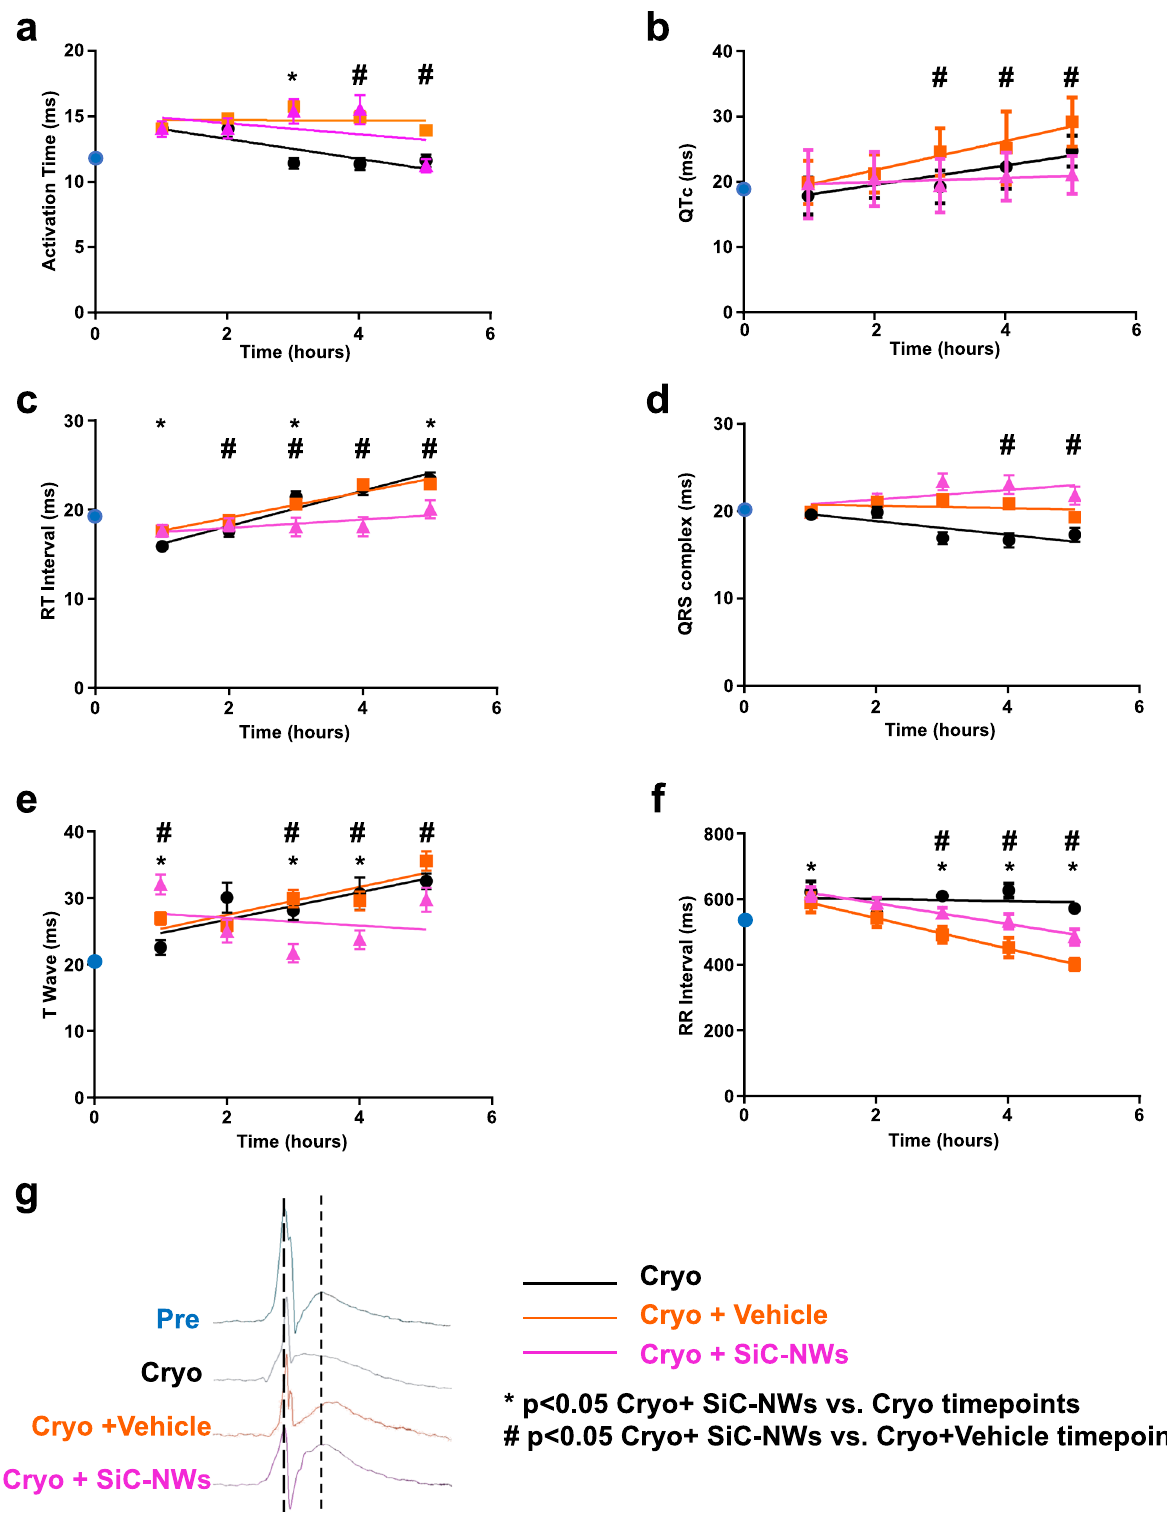
Fig. 8 Recovery of epicardial electrograms parameters over time for the MI model used. a Activation time. b QTc duration. c RT interval duration. d QRS complex duration. e T-wave duration. f RR interval duration. Blue dots: data measured before cryoinjury (Pre). Black dots: Cryo. Orange squares: Cryo + Vehicle. Pink triangles: Cryo + SiC-NWs. Colored lines: linear regression in the three conditions. Data are expressed as mean ± S.E.M. Statistical signi fi cance set at p < 0.05 (unpaired two-sided Student ’ s t -test). g Time-matched EG overlapping of the four different conditions. Source data are provided as a Source Data fi